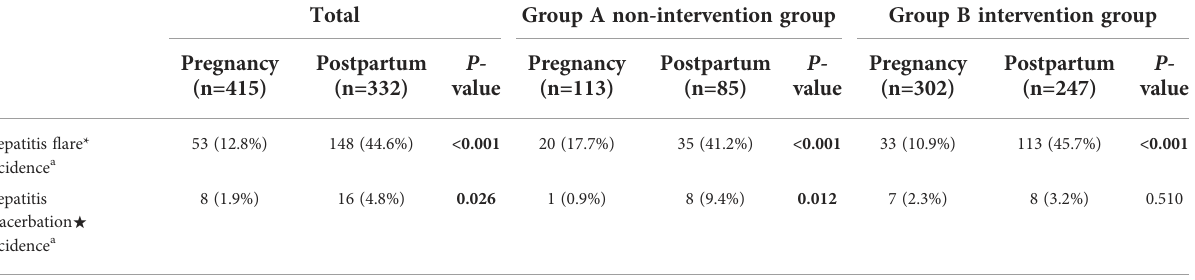
TABLE 3 Comparison of incidence of hepatitis fl are during pregnancy and